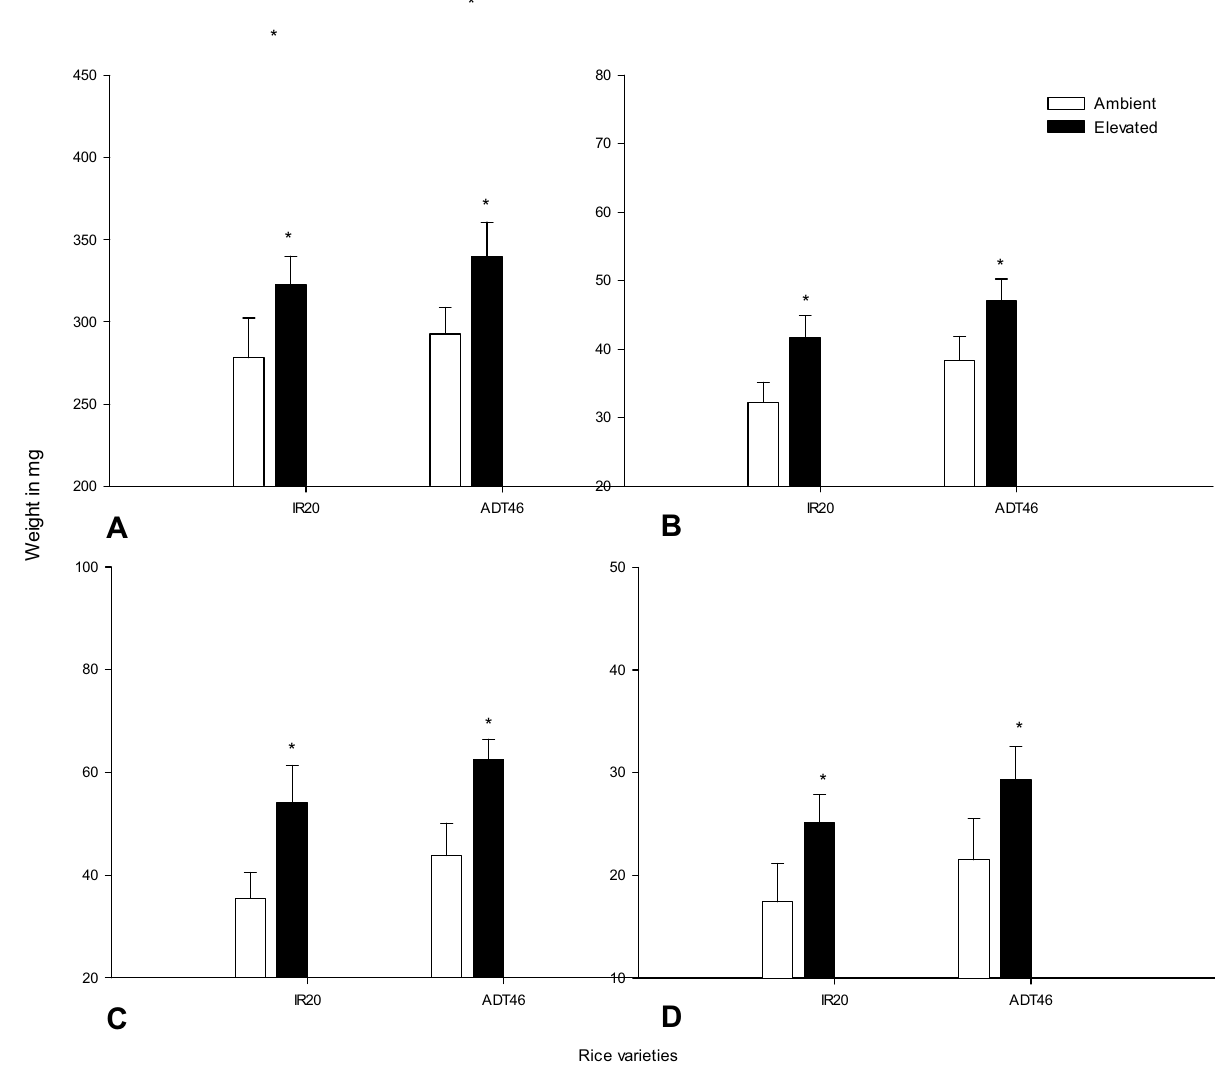
Figure 2. Effect of e CO 2 on shoot ( A – B ) and root ( C – D ) weight of different rice varieties (Values are means ± SEM of five replications) (Mean (± SEM) followed by the symbol * in an individual experiment indicate significant difference (P < 0.05) in a Tukeys test) (ns-non